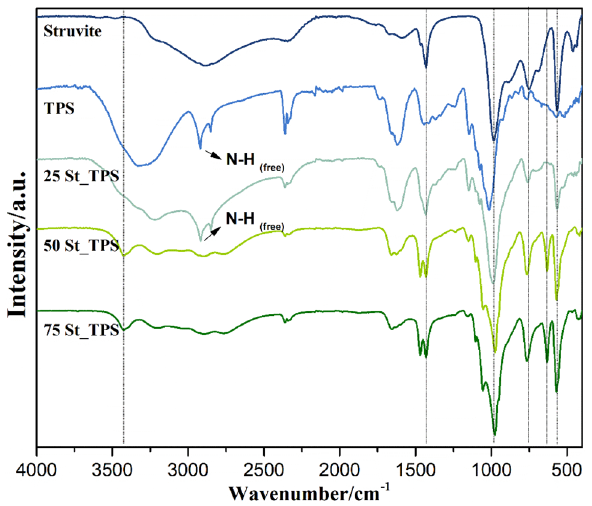
Figure 2. Normalized FTIR spectra of pure struvite, TPS, and composites 25 St-TPS, 50 St-TPS, and 75 St-TPS.